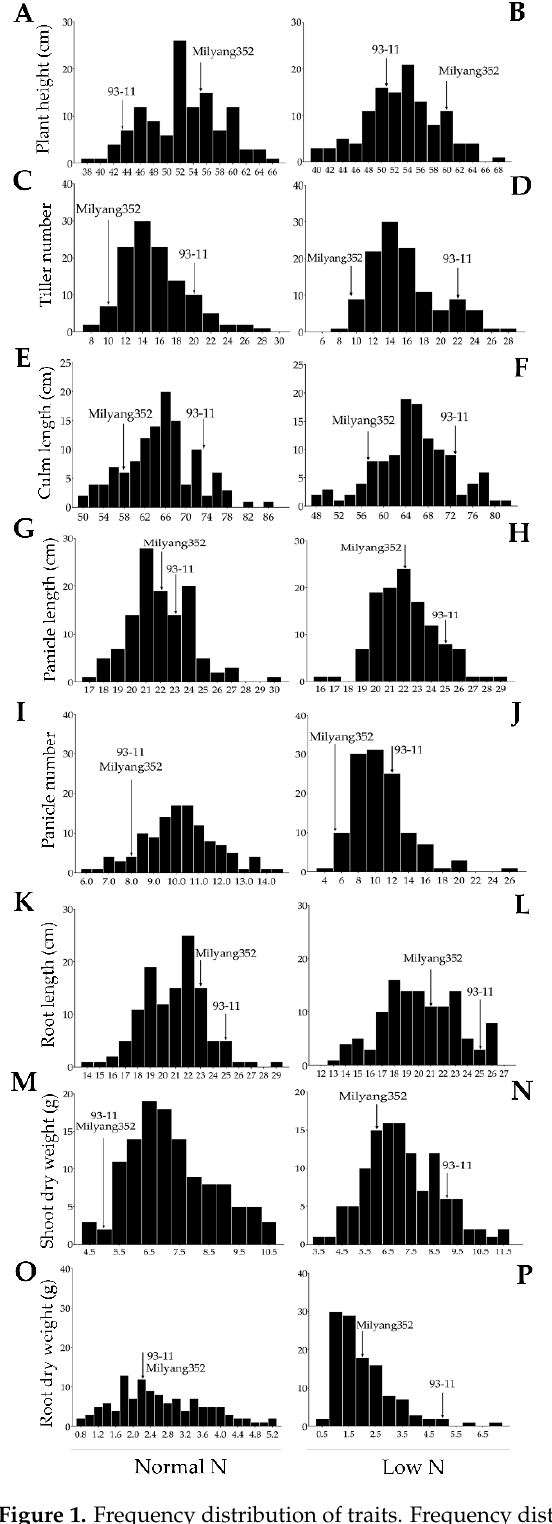
Figure 1. Frequency distribution of traits. Frequency distribution of plant height of a DH population grown under a normal ( A ) and low ( B ) nitrogen (N) cultivation regimes. Frequency distribution of tiller number under normal ( C ) and low ( D ) nitrogen levels. Frequency distribution of culm length ( E , F ) and panicle length ( G , H ) under normal and low N cultivation. Frequency distribution of panicle number ( I , J ) and root length ( K , L ) under normal and low N cultivation. Frequency distribution of shoot ( M , N ) and root ( O , P ) dry weights under normal and low N levels.